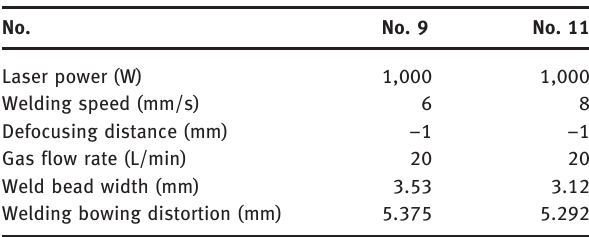
Table 10: Welding parameters and bead width corresponding to Figure 12.